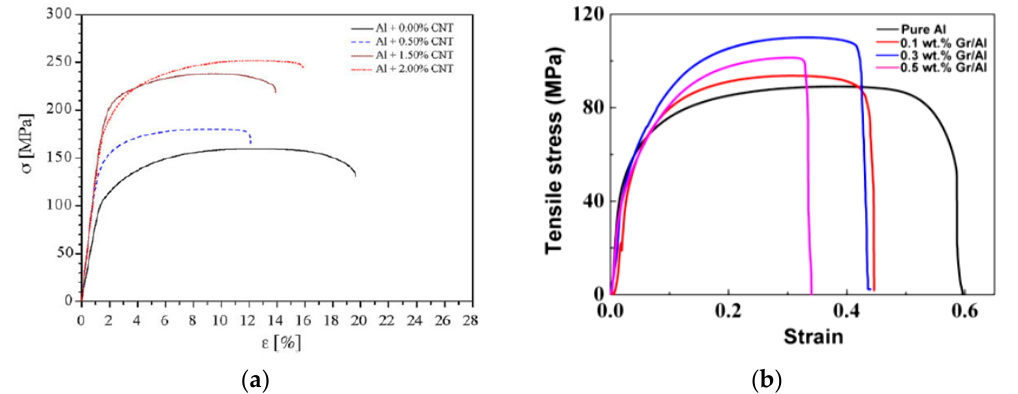
Figure 3. Tensile stress-strain curves of Al nanocomposites reinforced by ( a ) Carbon Nanotubes (CNTs)[96], ( b ) graphene [24], Reproduced from [96 and 24], with permission from Elsevier, 2009 and 2016.